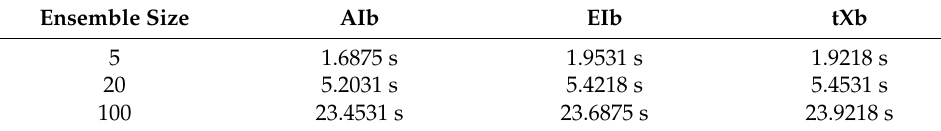
Figure 2. RMSEs of different ensemble sizes in the imperfect model with AIb (blue bar), EIb (orange bar) and tXb (yellow bar) for variable x 2 , ω , η . It is the time mean of the RMSEs in the last 5000 TUs. Table 1. Comparison of calculation time for different inflation